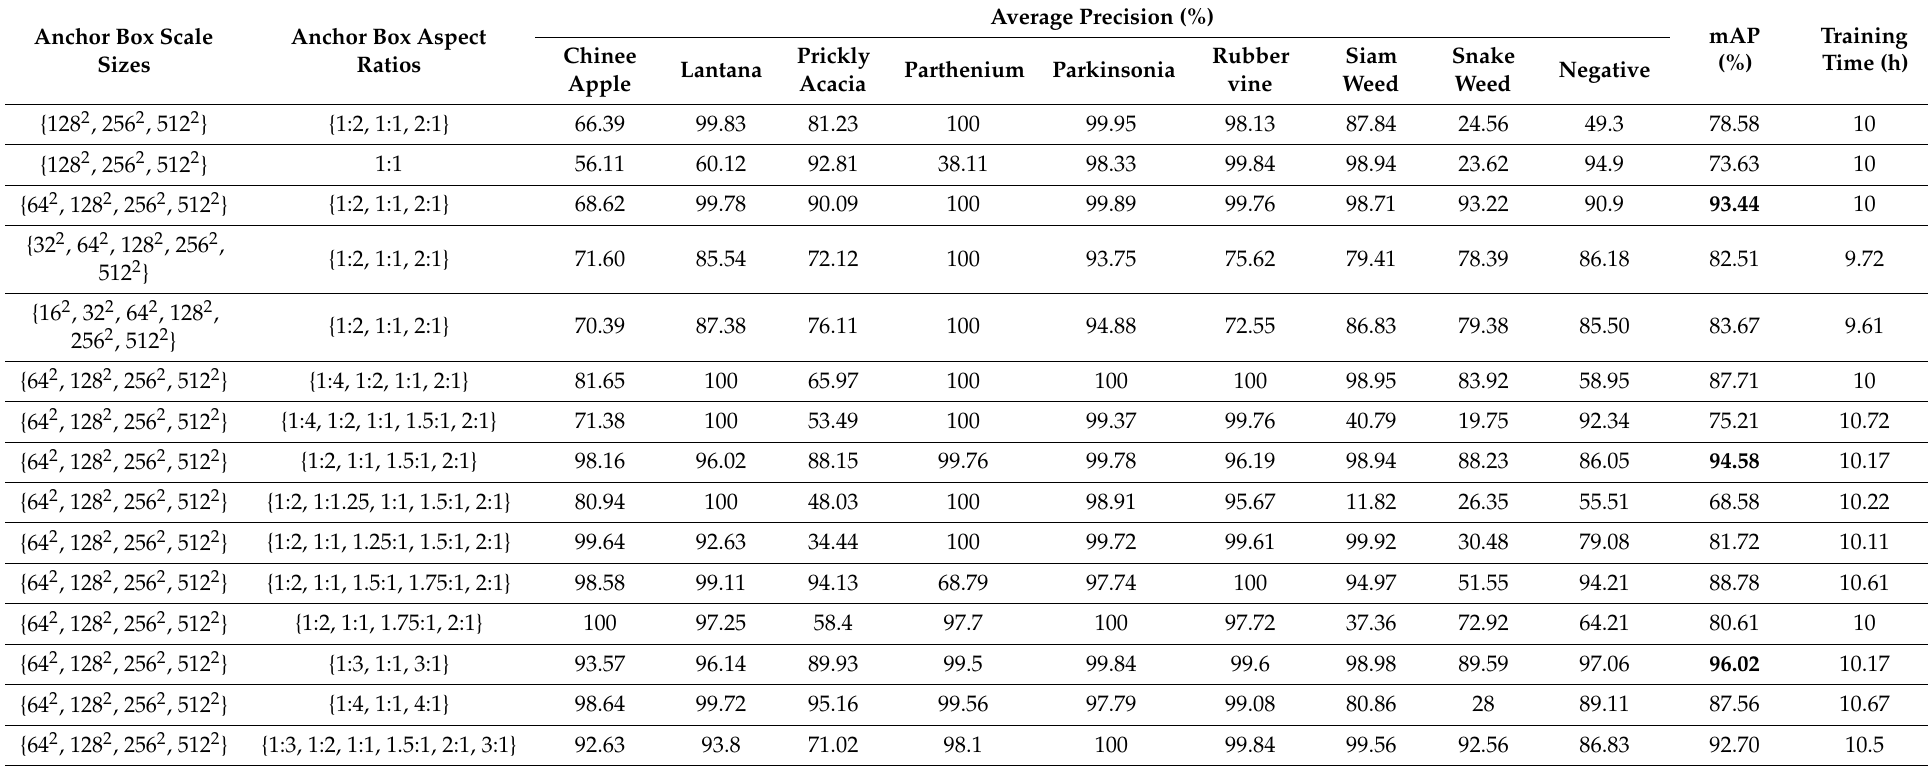
Table 1. Effects of anchor scale sizes and aspect ratios on the average precision of each class. Anchor Box